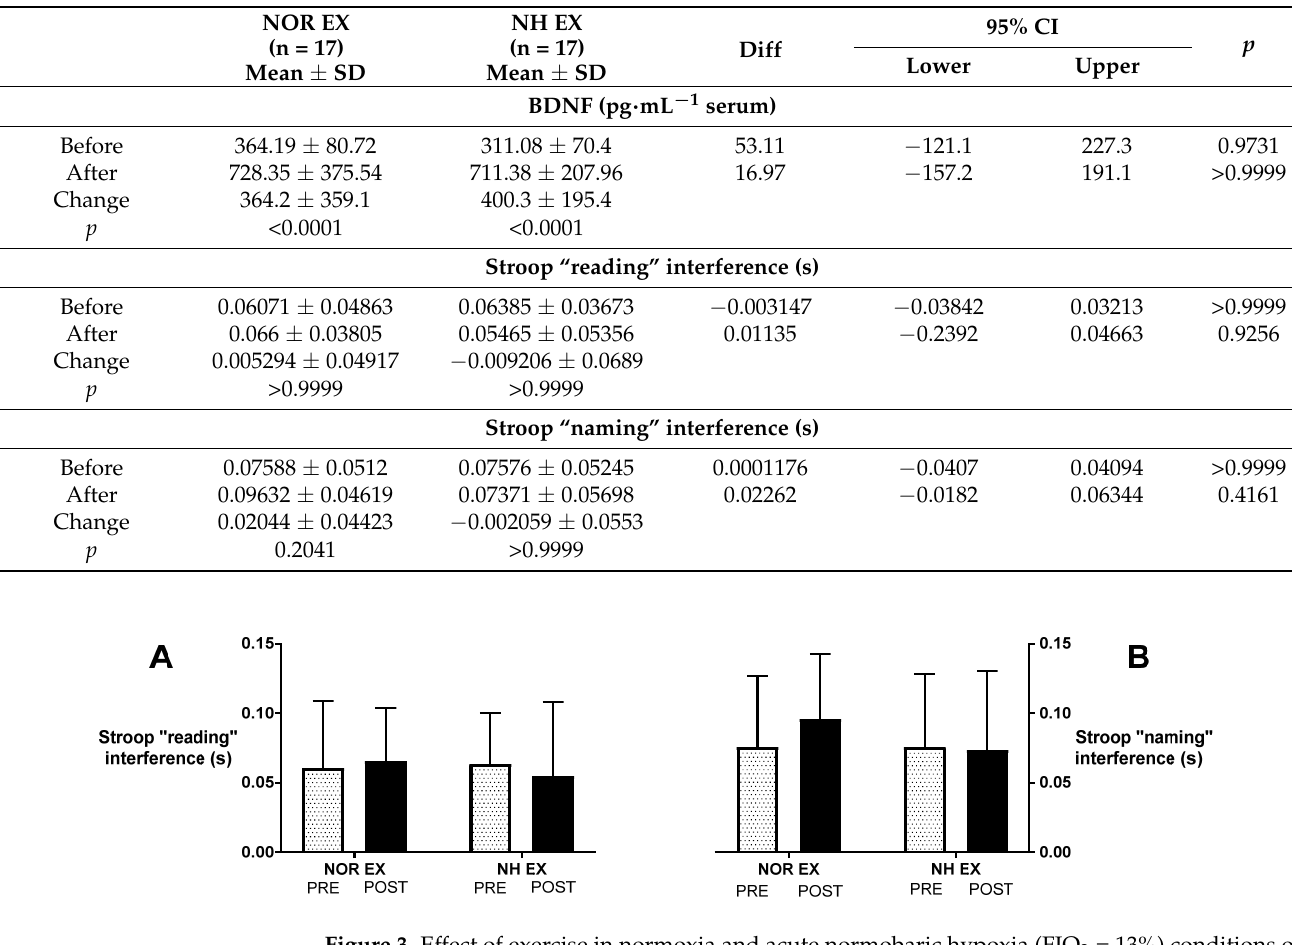
Figure 3. Effect of exercise in normoxia and acute normobaric hypoxia (FIO 2 = 13%) conditions on post-exposure interference values in reading ( A ) and in naming ( B ). Values are means. Error bars indicate ± SD (standard deviation). Table 2. Effect of intervention on BDNF concentration and Stroop interference results.